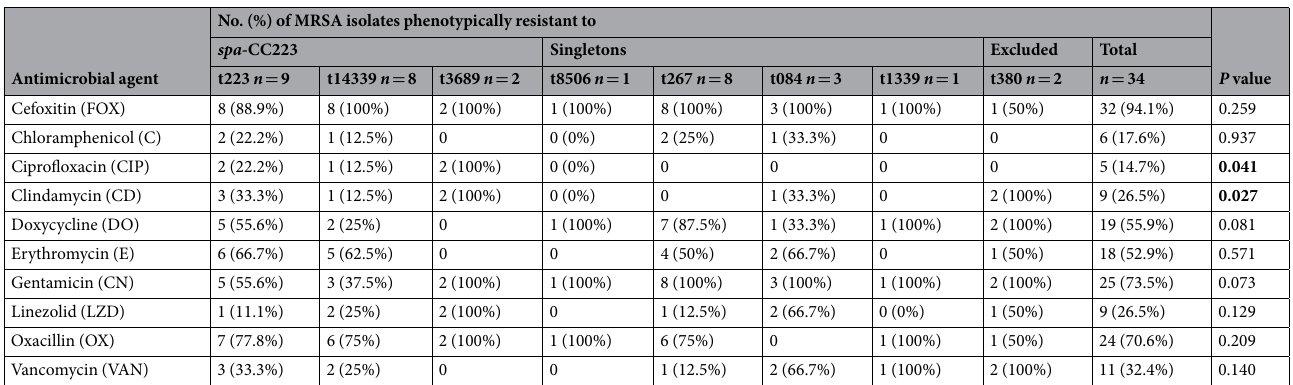
Table 7. Antimicrobial resistance rates among the investigated MRSA isolates in relation to different clonal lineages. Data indicate the number and percentage (%) of full resistance for each respective antimicrobial agent; isolates showing intermediate resistance to the tested antimicrobials are not included in the table. All the tested isolates were susceptible to cefaclor, ceftriaxone, imipenem, and neomycin. spa- CC: denotes spa clonal complex as determined by the Based Upon Repeat Pattern (BURP) algorithm in the Ridom StaphType software with a distance cost of ≤ 5; excluded: denotes entries excluded from BURP clustering because the spa repeat pattern comprised fewer than five repeats. a P values calculated using chi-squared tests of 2 × 8 contingency tables. P values < 0.05 are highlighted in